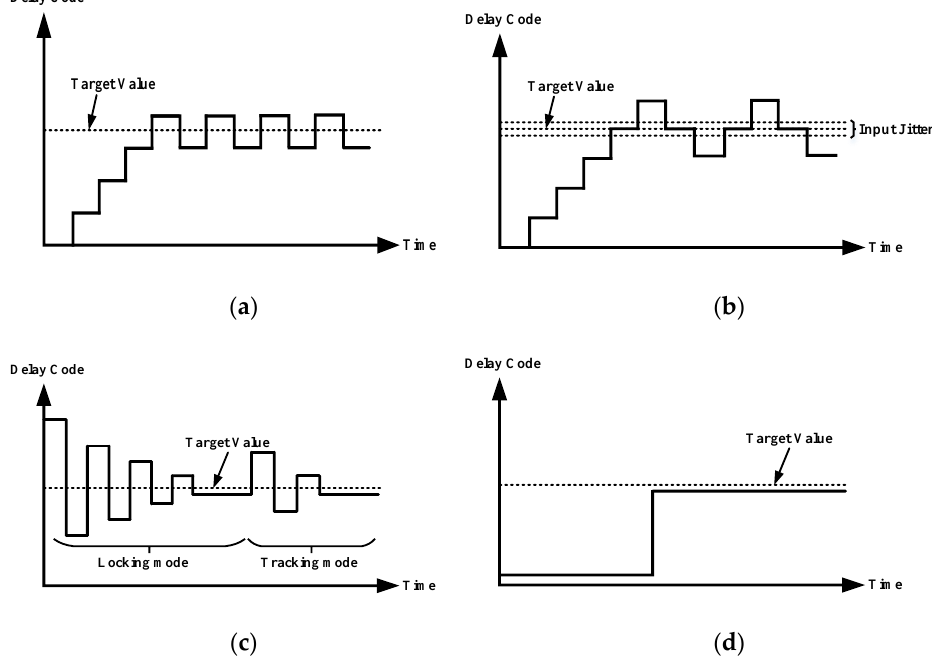
Figure 4. ( a ) Locking process of the counter-based DLL; ( b ) Worst case on counter-based DLL with a small input clock jitter; ( c ) Locking process of the main DCDL; ( d ) Control code of the replica DCDL.